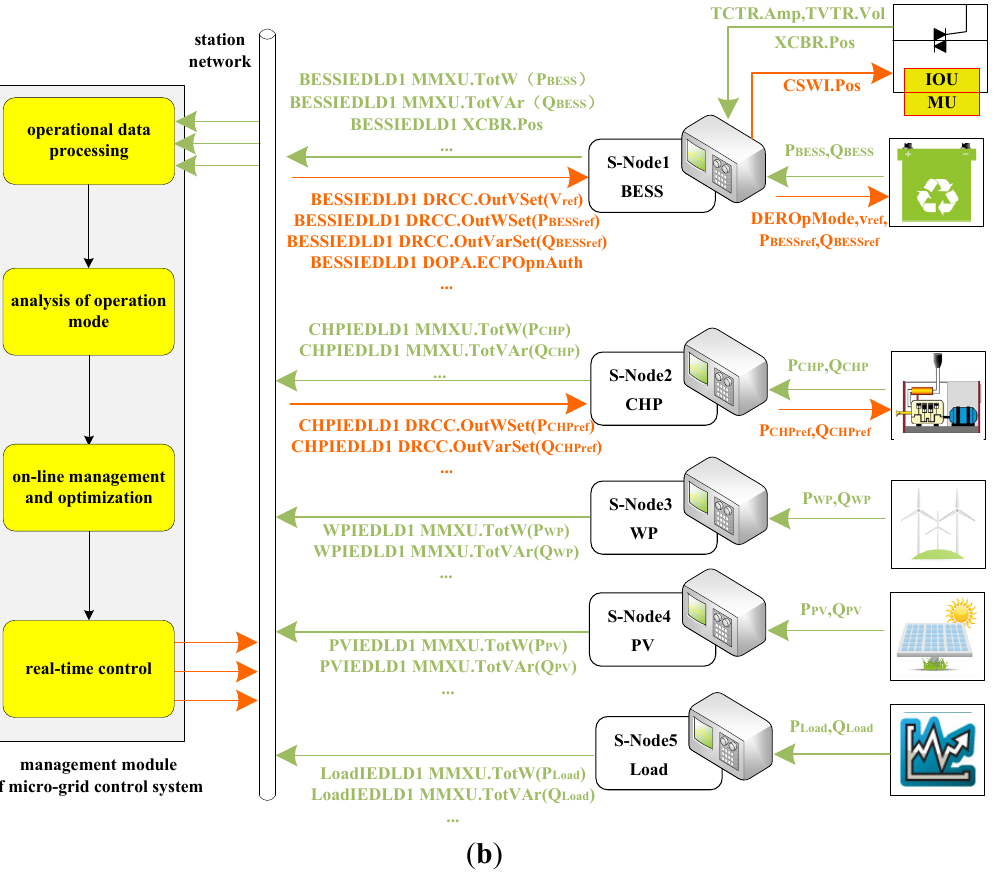
Figure 5. Data exchange in “plug and play” integration: ( a ) Data exchange for S-Node; ( b ) Data exchange for